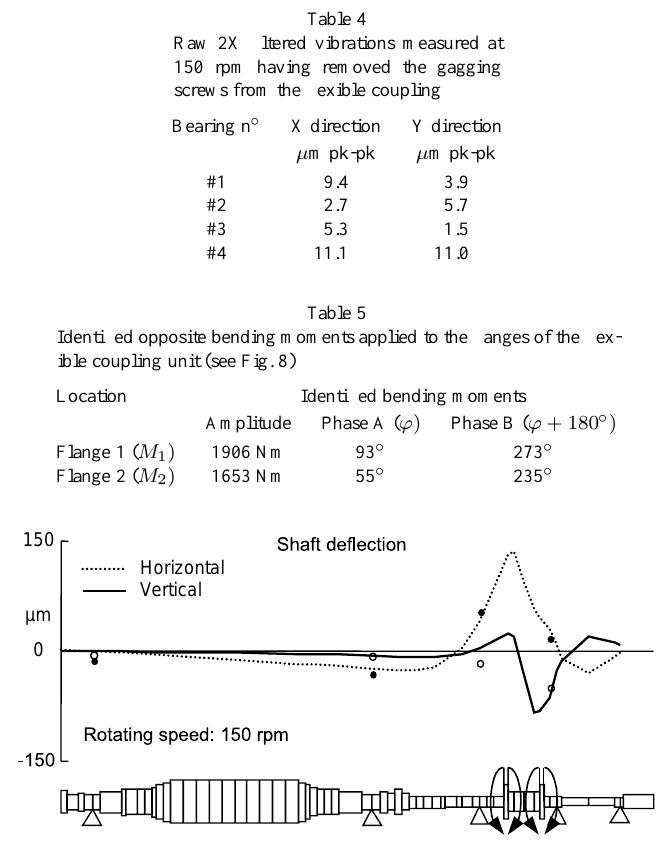
Fig. 8. Dynamic defelction of the rotor-train induced at 150 rpm by the identified bending moments M 1 and M 2 . Solid dots: experimental deflection in horizontal direction. Circles: experimental deflections in vertical